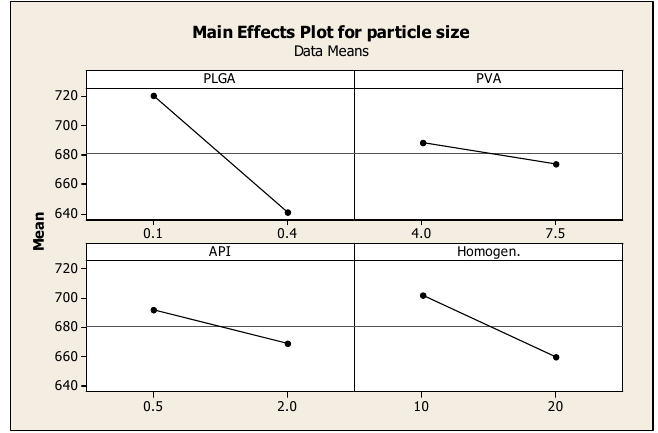
Figure 2. Main effects plot showing the effect of PLGA, PVA, prednisolone concentrations and homogenization time on the particle size of PLGA nanoparticles.